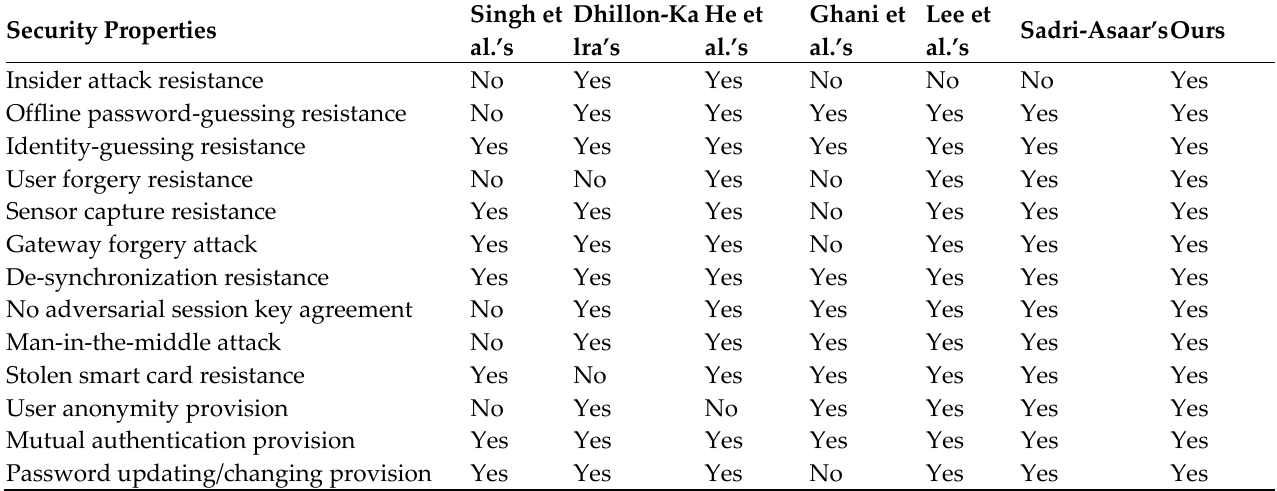
Table 8. Comparison of security and functional features.